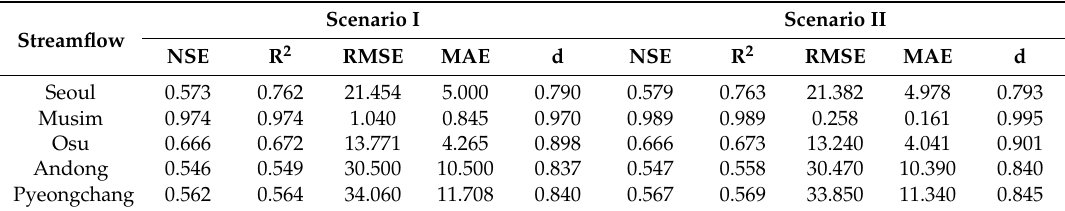
Table 2. Nash-Sutcliffe efficiency coefficient (NSE), determination coefficient (R 2 ), root mean square error (RMSE), mean absolute error (MAE), and index of agreement (d) for Scenario I and Scenario II for streamflow for study watersheds.